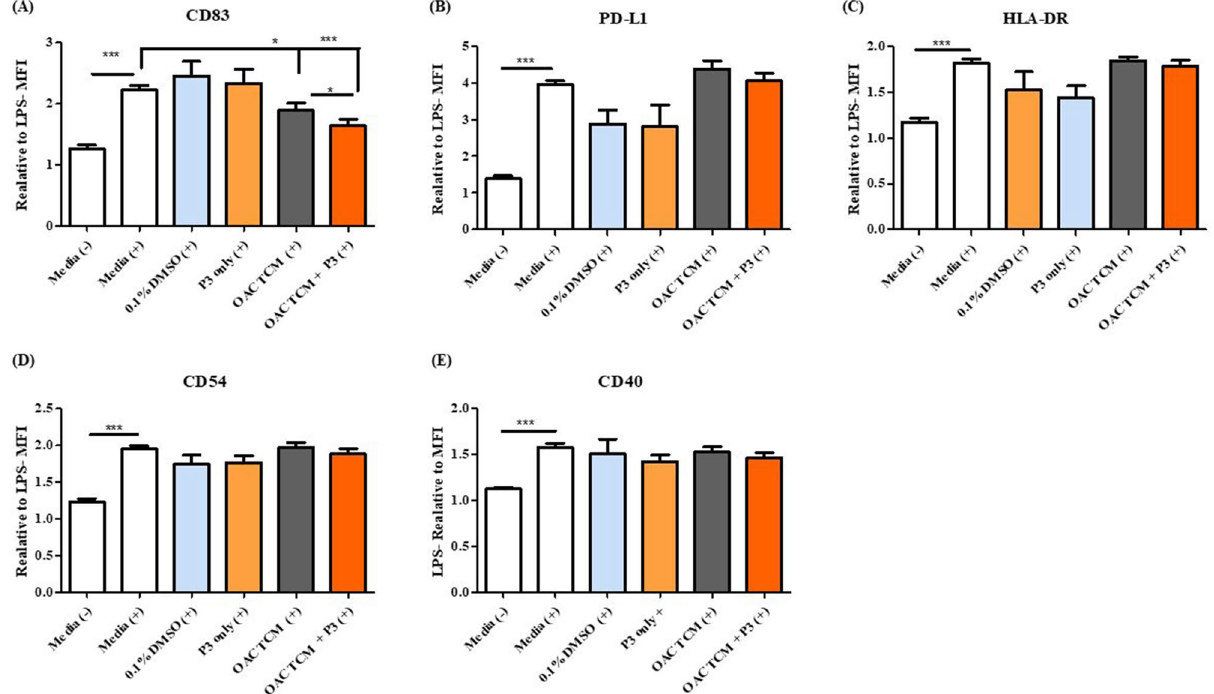
Figure 7. OAC TCM and Pyrazinib (P3) treated TCM significantly reduced expression of CD83 but did not alter the expression of PD-L1, CD40, HLA-DR or CD54 expression on monocyte derived dendritic cells following stimulation with LPS. The effect Pyrazinib (P3) and Pyrazinib (P3) treated TCM on the expression of dendritic cells maturations markers was assessed by flow cytometry. ( A ) CD83 expression on monocyte derived dendritic cells following incubation with LPS- and LPS + M199, 0.1% DMSO + LPS, 10 µM Pyrazinib (P3) + LPS, 0.1% DMSO treated OAC TCM + LPS and OAC TCM treated with Pyrazinib (P3) + LPS. ( B ) PD-L1 expression on monocyte derived dendritic cells following incubation with LPS- and LPS + M199, 0.1% DMSO + LPS, 10 µM Pyrazinib (P3) + LPS, 0.1% DMSO treated OAC TCM + LPS and OAC TCM treated with 10 µM